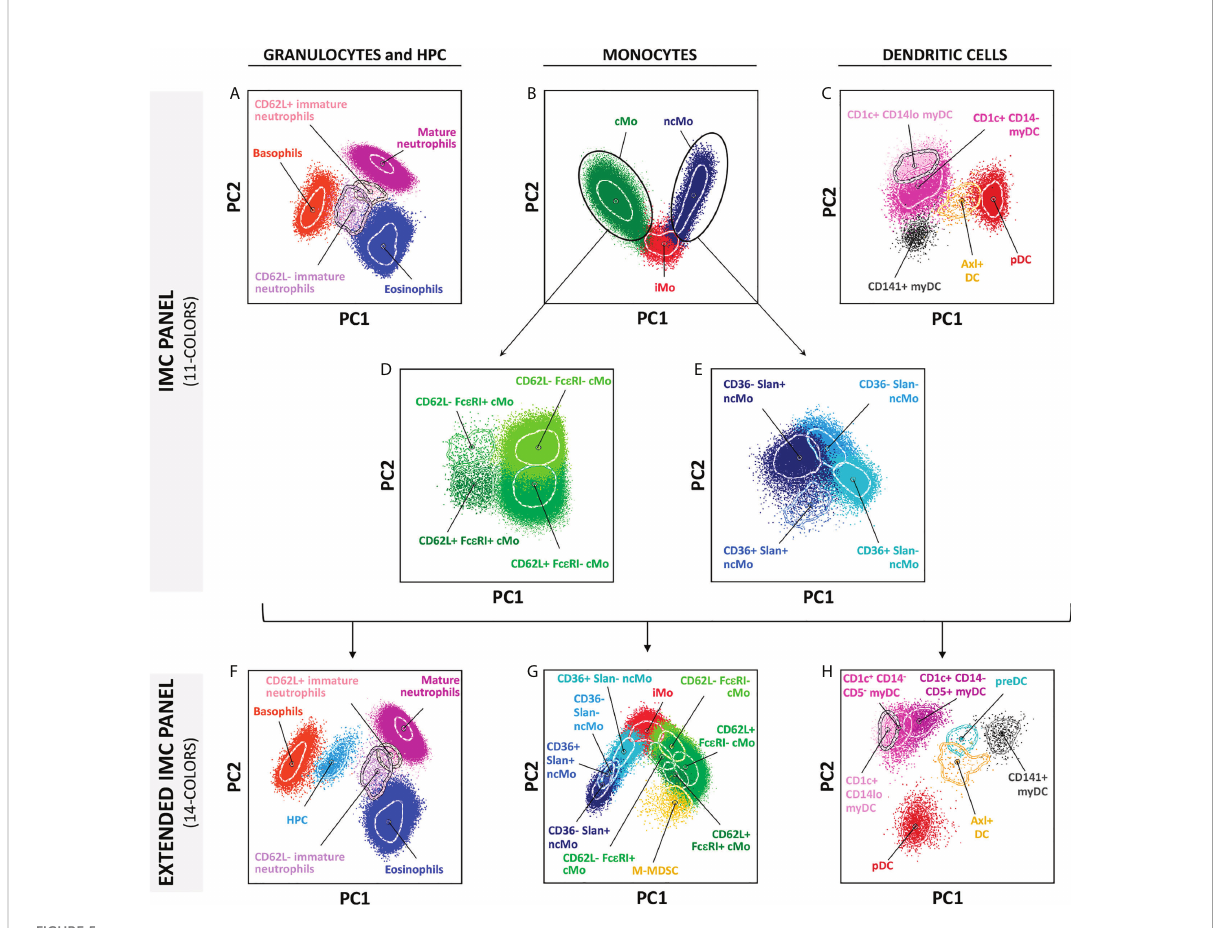
FIGURE 5 Multidimensional representation (principal component analysis – PCA) of the cell populations identi fi ed in one representative adult blood sample, employing the two versions of the innate myeloid cell panel. (A – E) show the 19 populations identi fi ed using version 3 (11-colors) antibody combination, whereas (F – H) depict the 23 populations identi fi ed in the extended version of the panel (version 4; 14-colors). Solid circles represent median values for the parameters evaluated, inner dotted lines depict the fi rst standard deviations for each population identi fi ed. PC, principal component; cMo, classical monocytes; iMo, intermediate monocytes; ncMo, non-classical monocytes; myDC, myeloid dendritic cells; pDC, plasmacytoid dendritic cells; M-MDSC, monocytic-myeloid derived suppressor cells; HPC, hematopoietic precursor cells; preDC, CD100 + dendritic cell